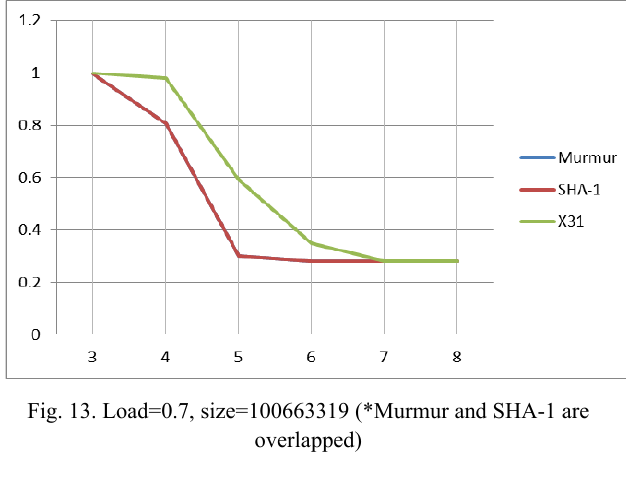
Fig. 13. Load=0.7, size=100663319 (*Murmur and SHA-1 are